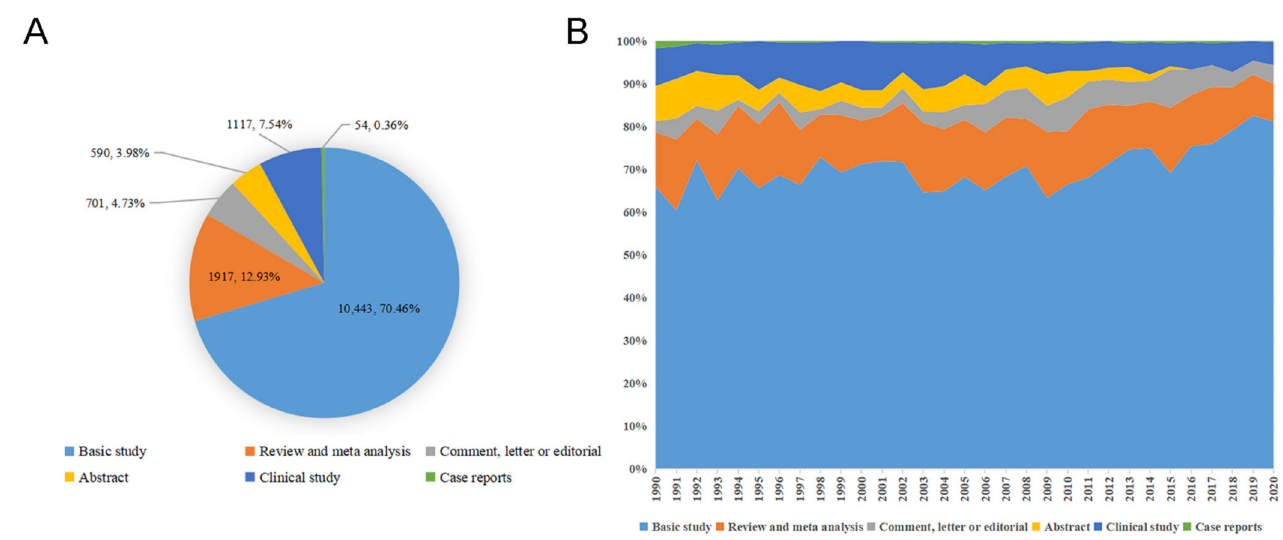
Figure 2. Distribution of article type. ( A ) total number and proportion of different article types in the past three decades; ( B ) distribution of different article types per year.